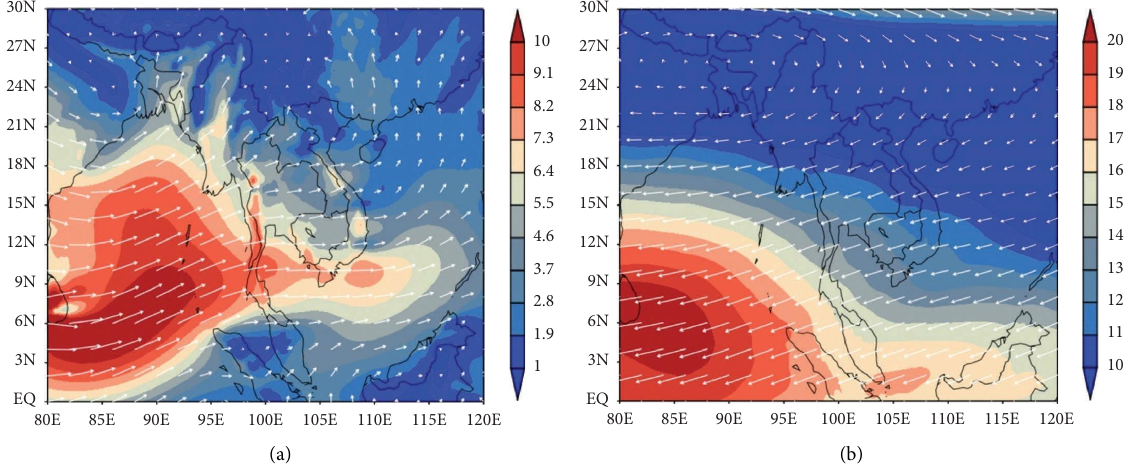
Figure 8: Climatology of southwest monsoon seasonal (JJAS) average wind speed (shaded) and direction (arrow) of (a) 850hPa level and (b) 200hPa level during (1991–2020).